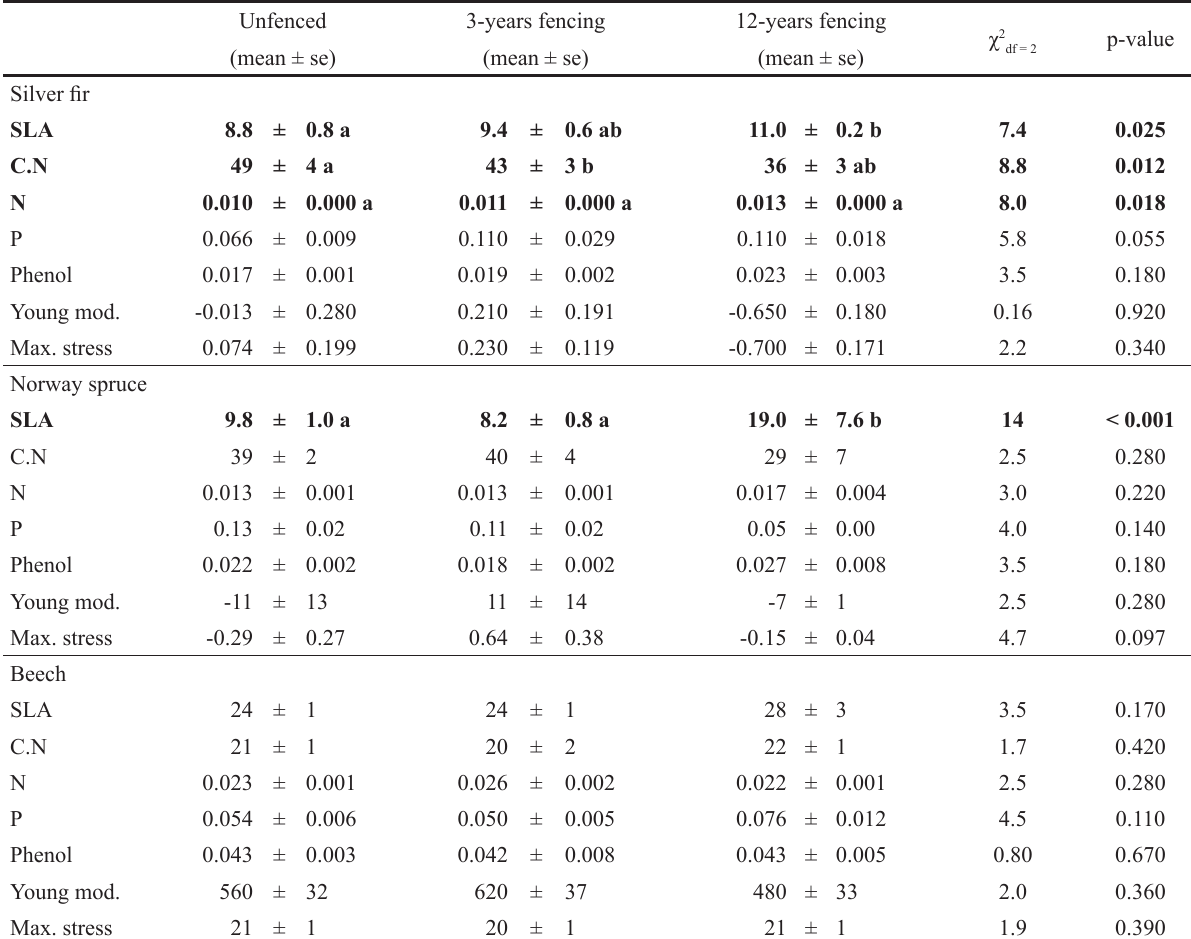
Table 1 – Foliar trait differences between individuals exposed and unexposed to deer (mean ± standard error). The effect of fencing on each functional trait was tested with mixed models [Y ~ fencing + (1| experimental unit )]. Bold values indicate